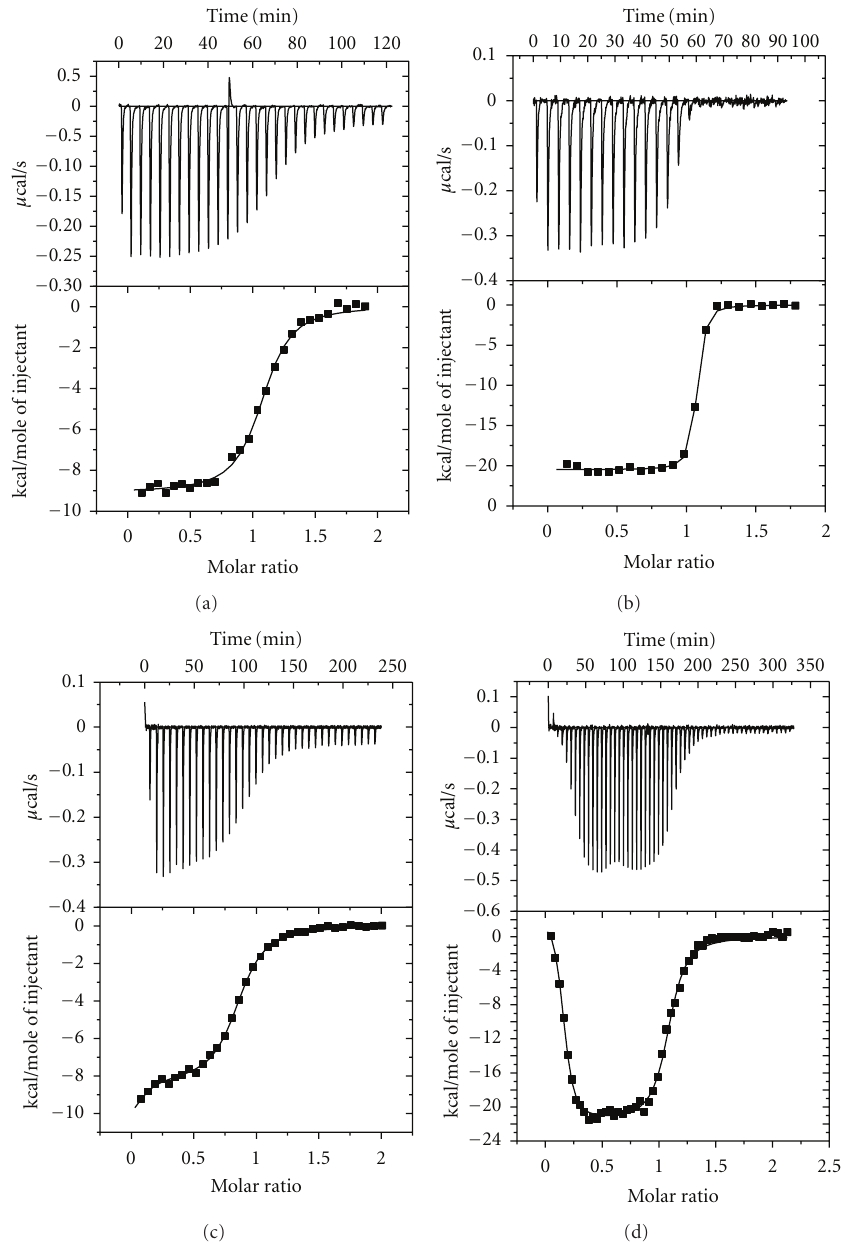
Figure 9: Titration calorimetry of Pop5-RPP30 binding reveals net 1 :1 stoichiometry but higher-order binding. Top panels: Representative ITC thermograms obtained upon titration of Pfu Pop5 into Pfu RPP30 at 55 ◦ C. Bottom panels: Time-integration for each peak in the thermogram after normalizing per mol of injectant (squares). Titrations, (a, no salt) and (b, 130 mM KCl), were performed with 9.89 and 4.95 μ M RPP30, respectively, in the cell and can be fit by a single site binding model, with apparent dissociation constants of 124 ± 13 and 3.5 ± 0.6nM, respectively. Experiments performed with 14.8 μ M RPP30 in the cell (c: no salt, d: 150 mM NaCl) yielded more complex thermograms that could only be fit by invoking two-site, or more complex binding models, consistent with higher-order assembly. Comparison of data at lower and higher ionic strength indicates binding is strongly favored by inclusion of moderate salt (e.g., 130 mM KCl) in the